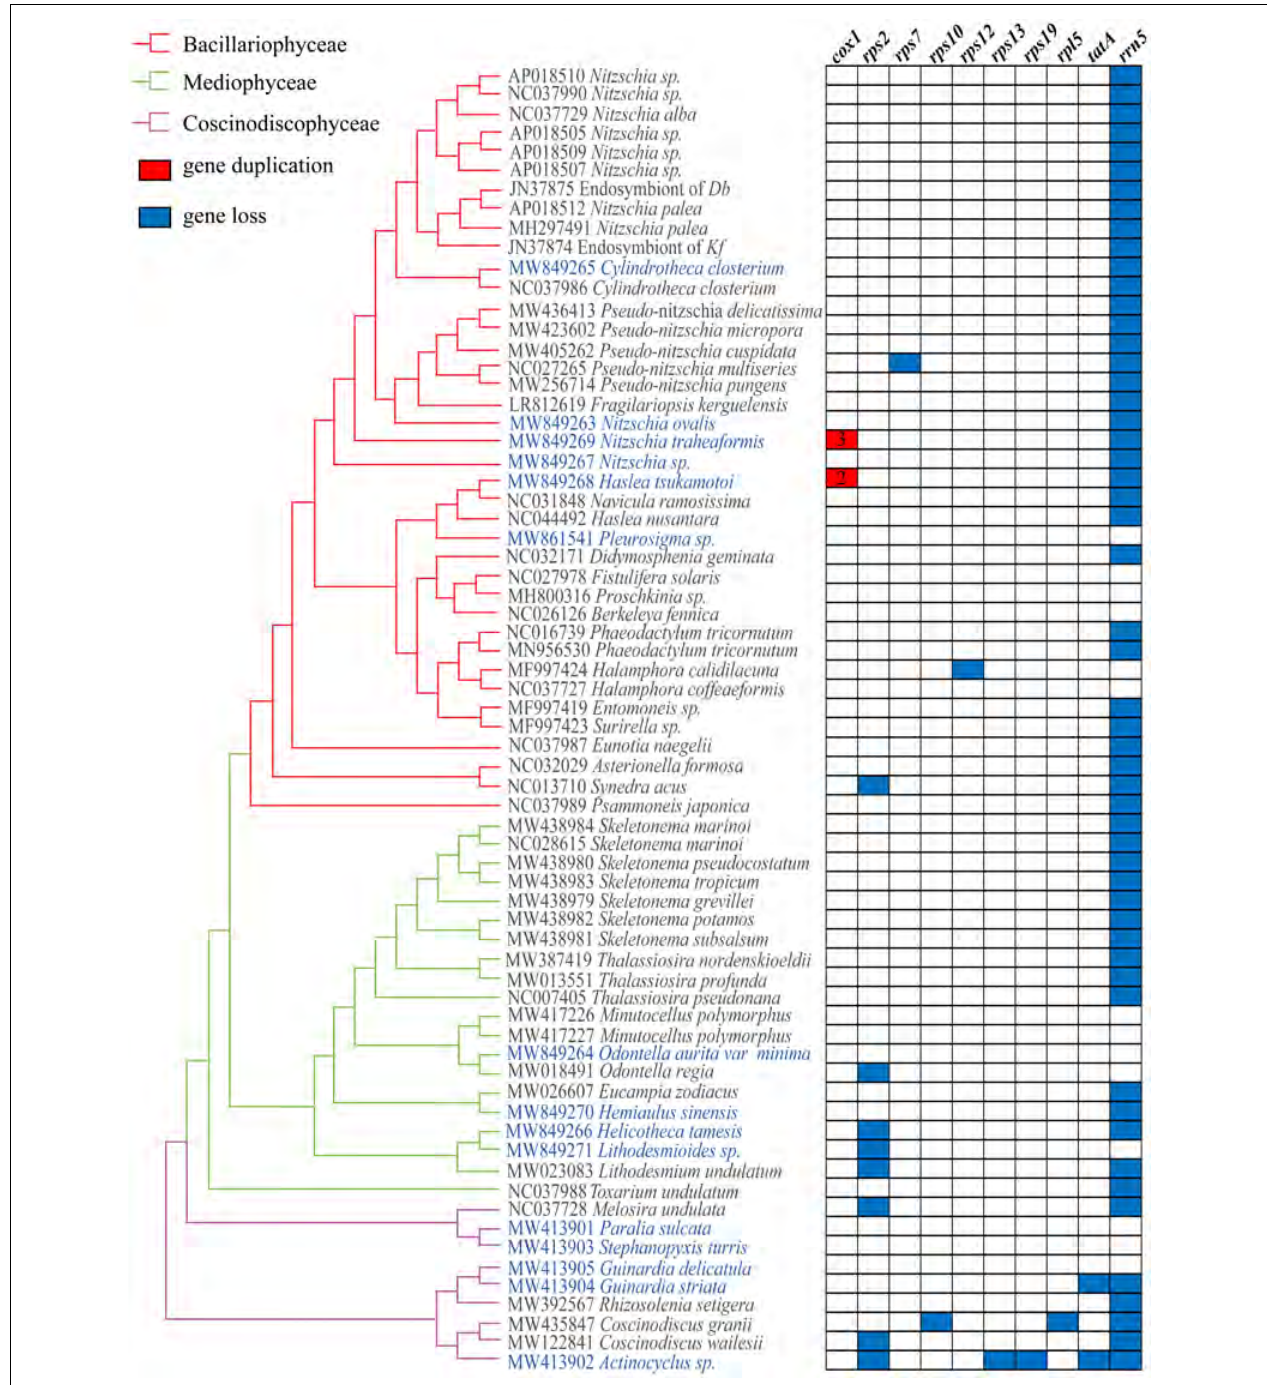
FIGURE 4 | Gene losses and gains in diatom mtDNAs. The matrix shows 10 genes variably present among 68 mtDNAs.